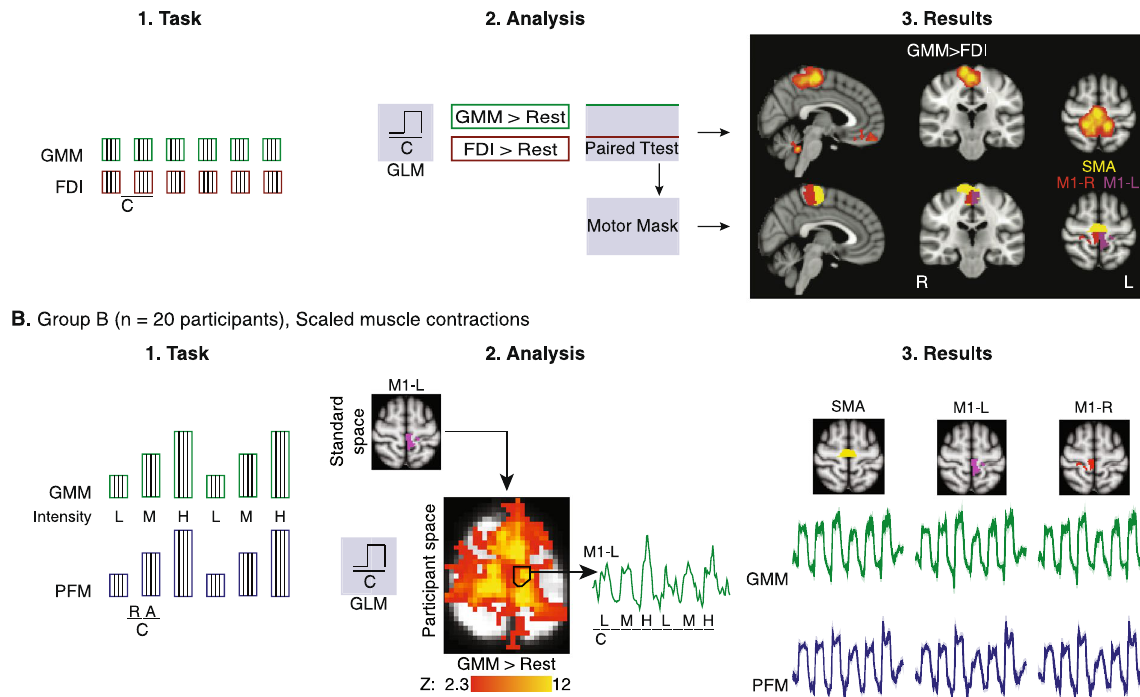
Figure 2. Functional magnetic resonance imaging (fMRI) evidence of non-localized control of human pelvic floor muscles (PFM). ( A - 1 ) fMRI data were collected while a first group of participants (Group A) voluntarily activated the first dorsal interosseous muscle (FDI) and the gluteus maximus muscle (GMM) in blocks at a comfortable level. ( A-2,3 ) Contrast of voluntary GMM activation greater than voluntary FDI activation produced significant brain activation in distinct brain areas (Z > 2.3, p < 0.05, cluster corrected), including three distinct ROIs in the motor cortex: supplementary motor cortex (SMA) and bilateral primary motor cortex (M1-L and M1-R). ( B-1 ) fMRI data were collected while a different set of participants (Group B) voluntarily activated the GMM and PFM in blocks to three distinct levels: low (L), medium (M), and high (H). ( B-2 ) The motor cortical ROIs (SMA, M1-L, M1-R) were projected into the native space to identify voxels in these ROI that were active (Z > 2.3, p < 0.05, cluster corrected) in the contrast of muscle activity compared to rest, regardless of contraction level. For each participant and ROI, BOLD signals extracted from the identified voxels were averaged. ( B-3 ) Activation significantly increased in all ROIs during increased voluntary GMM activation (gluteal-pelvic coordination pattern) and during increased voluntary PFM activation (isolated-pelvic coordination pattern). Specifically, activity significantly increased in SMA during increased voluntary GMM (p < 0.0001), in M1-L during increased voluntary GMM (p < 0.0001), in M1-R during increased voluntary GMM (p < 0.0001), in SMA during increased voluntary PFM (p < 0.0001), in M1-L during increased voluntary PFM (p < 0.0001), and in M1-R during increased voluntary PFM (p <